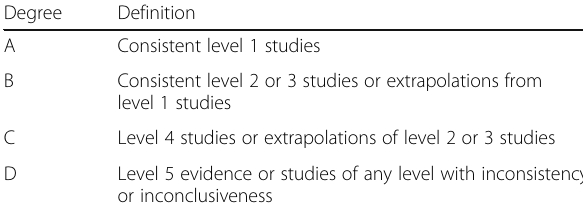
Table 2 Degrees of recommendation for each evidence